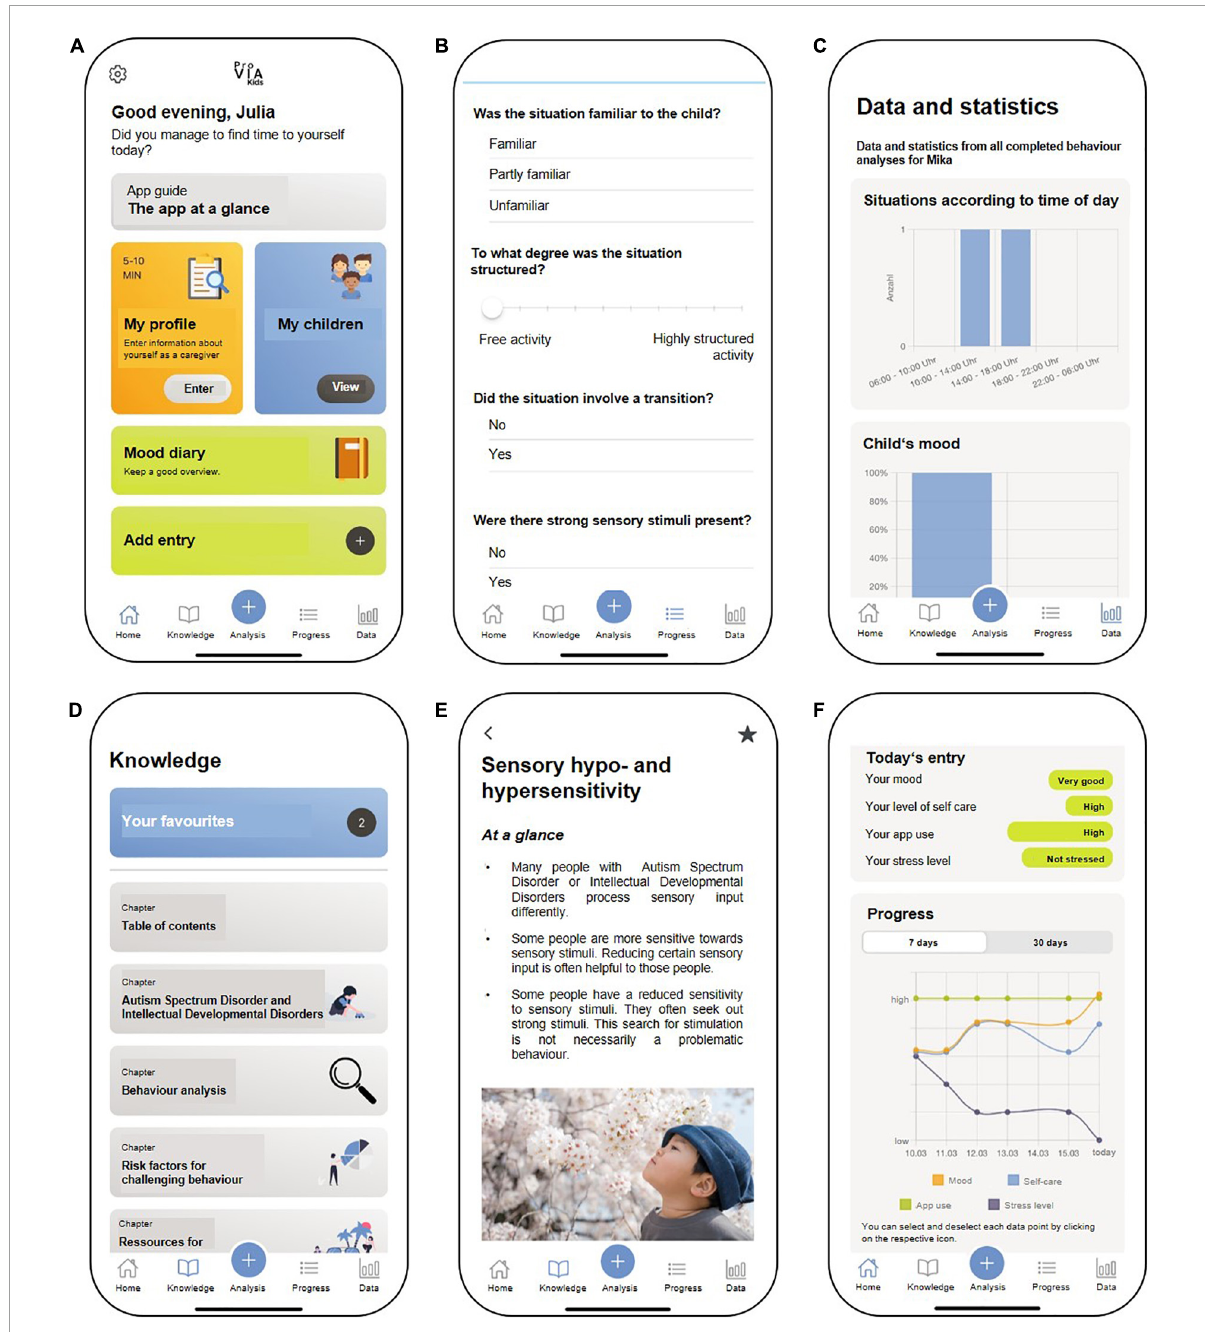
FIGURE2 Features of the ProVIA-Kids app (English mock-up, app not yet available in other languages): (A) Home screen, (B) Behaviour analysis algorithm, (C) Graphical display of the frequency of individual contributing factors for CB, (D) Menu for psychoeducational content, (E) Sample from chapter “Hypersensitivity” with recommendations for caregivers, (F) Mood diary. Source: Unsplash: https://unsplash.com/photos/Uu692